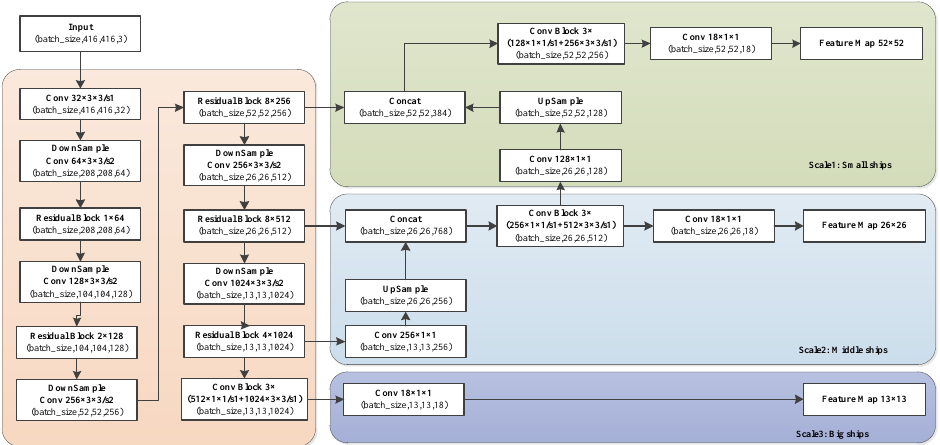
Figure 7. The architecture of the convolutional feature fusion ship detection network (CFF-SDN). The residual block and the convolution block are used to extract feature of ship targets. In the convolutional feature fusion network, scale 1 detects small ships, scale 2 detects medium ships, and scale 3 detects large